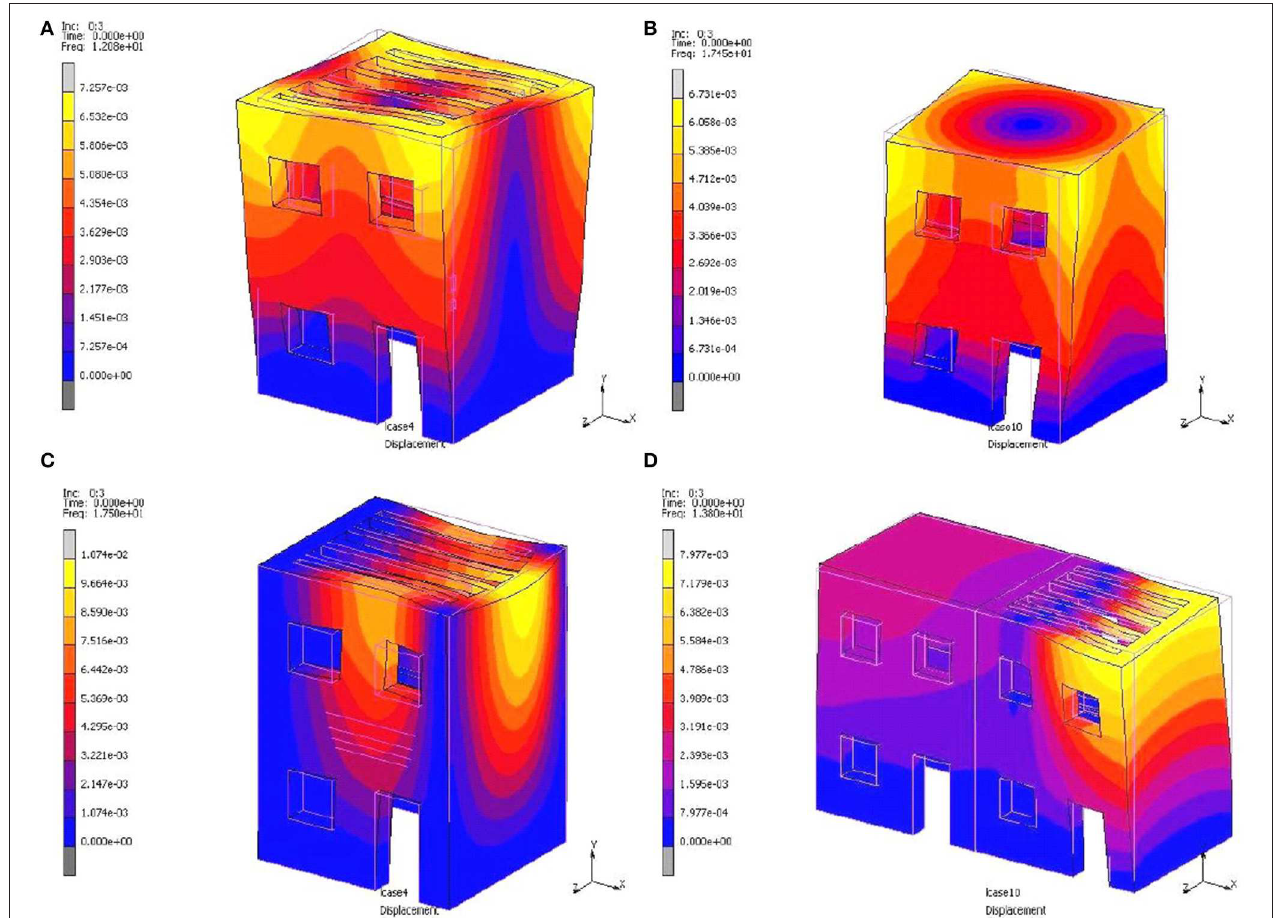
FIGURE 6 | Displacement of the third mode of models: (A) M1, (B) M2, (C) M1-L-fixed, and (D) M2-M1.